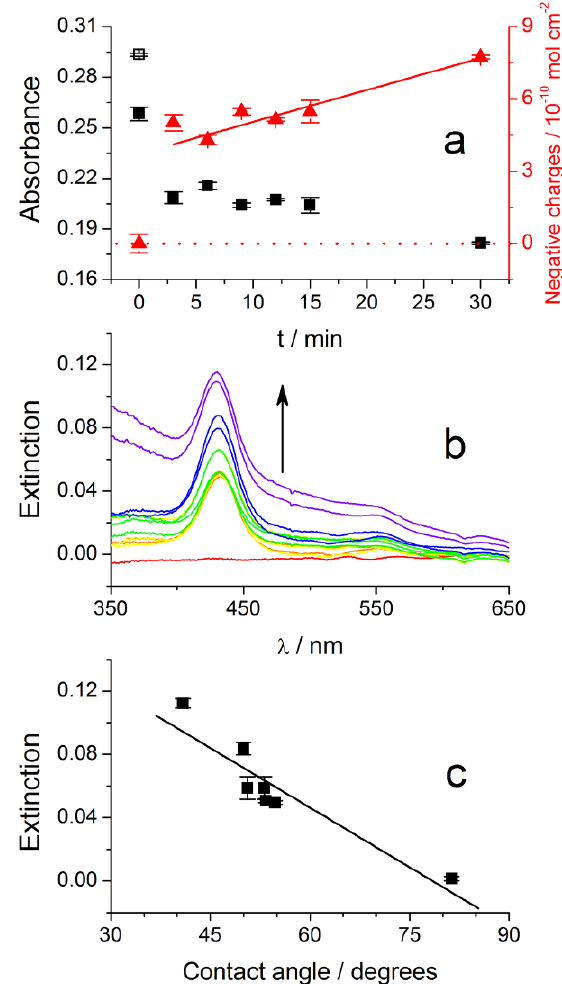
Figure 8. (a) UV/vis absorption at 425 nm of buffered CuT 4 solutions after Mylar TM soaking vs. Mylar TM hydrolysis time (filled squares, left Y axis; empty square: absorption of the reference solution), and the corresponding values of carboxylate densities expressed as moles of negative charges per unit surface (triangles, right Y axis) slope = (3.7 +/- 0.3)×10 10 mol cm –2 min –1 ; intercept = (1.3 +/- 0.1)×10 11 mol cm –2 ; R 2 = 0.95 (b) UV/Vis extinction spectra of the Mylar TM films after soaking in the porphyrin solutions, the arrow indicating the increase in Mylar TM hydrolysis time. (c) Corrected UV/vis extinction at 429 nm of Mylar TM films after soaking in CuT solutions vs. 4 films contact angle; slope = (-2.51 +/- 0.4)×10 3 deg -1 ; intercept = (0.20 +/- 0.02); R 2 =